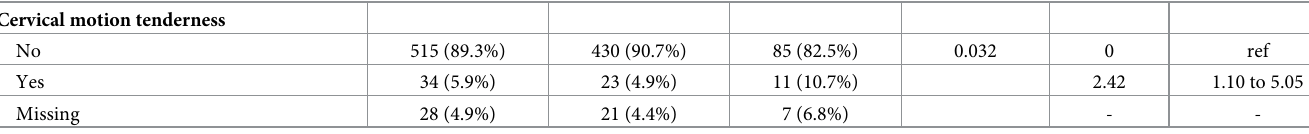
Table 4. Multivariate model for variables associated with C . trachomatis infection.